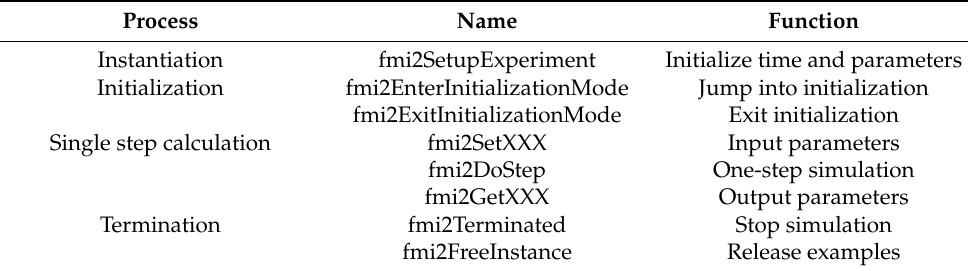
Table 1. FMI function name and effect.